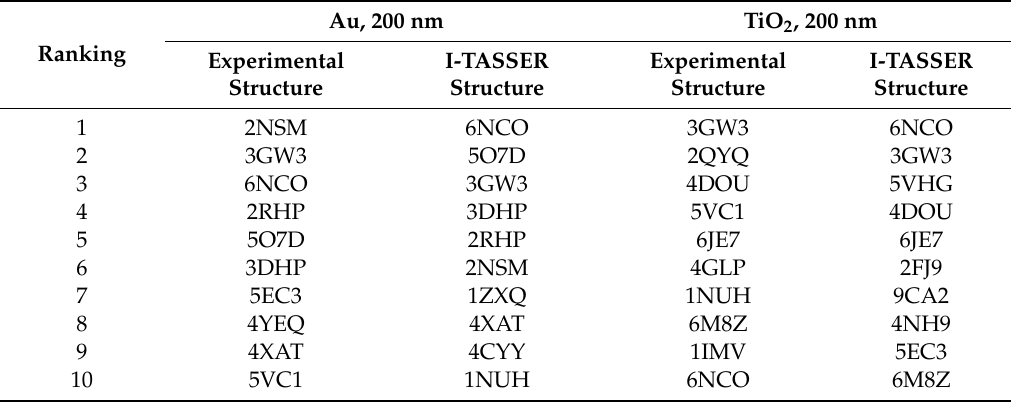
Table 4. Ranking of proteins by a ffi nity to the NP for both the experimental and computational structures, ordered by the binding strength for the most strongly binding proteins. (All ranking values for both NPs in all sizes are available in the attached E -ranking file on the supplementary section). Au, 200 nm TiO 2 , 200 nm Ranking Experimental I-TASSER Experimental I-TASSER Structure Structure Structure Structure 1 2NSM 6NCO